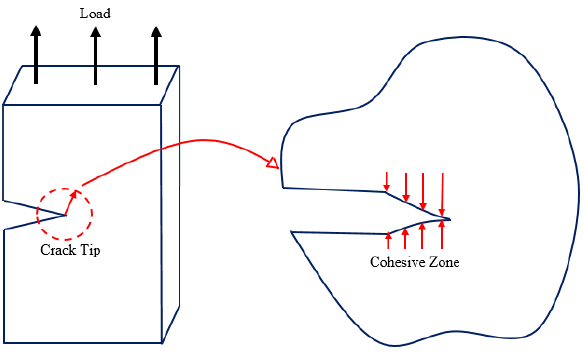
Figure 1. Schematic cohesive zone model.